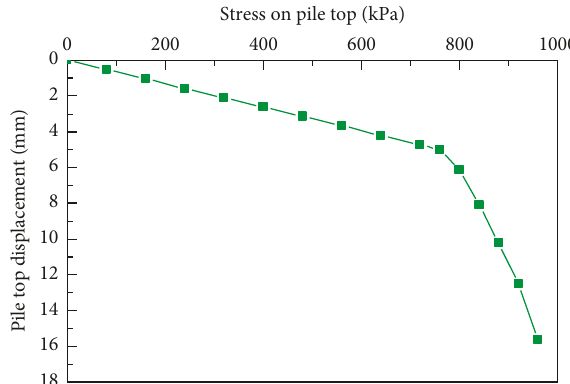
Figure 12: Load-settlement curve obtained by numerical calculation.